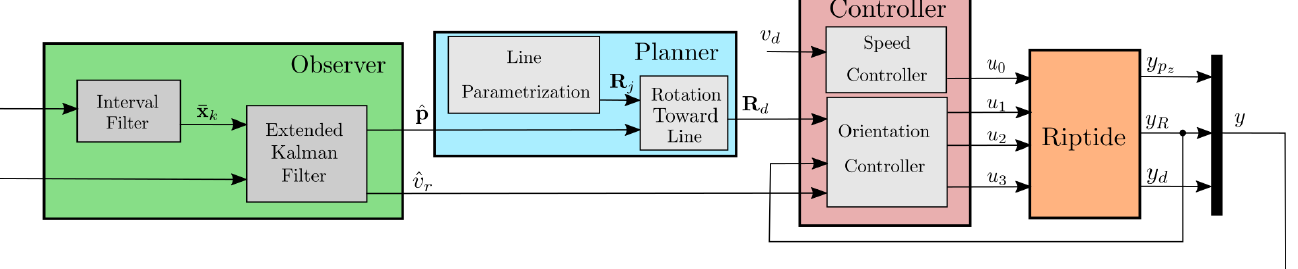
Figure 3. Block diagram of the closed loop